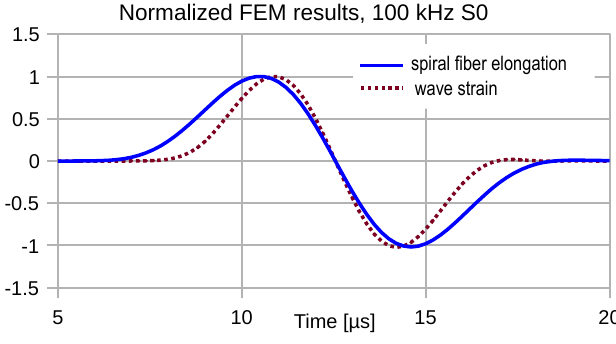
Figure 3. Simulated elongation of a five-turn fiber spiral in response to the shown single-sine strain pulse excitation with f 0 =